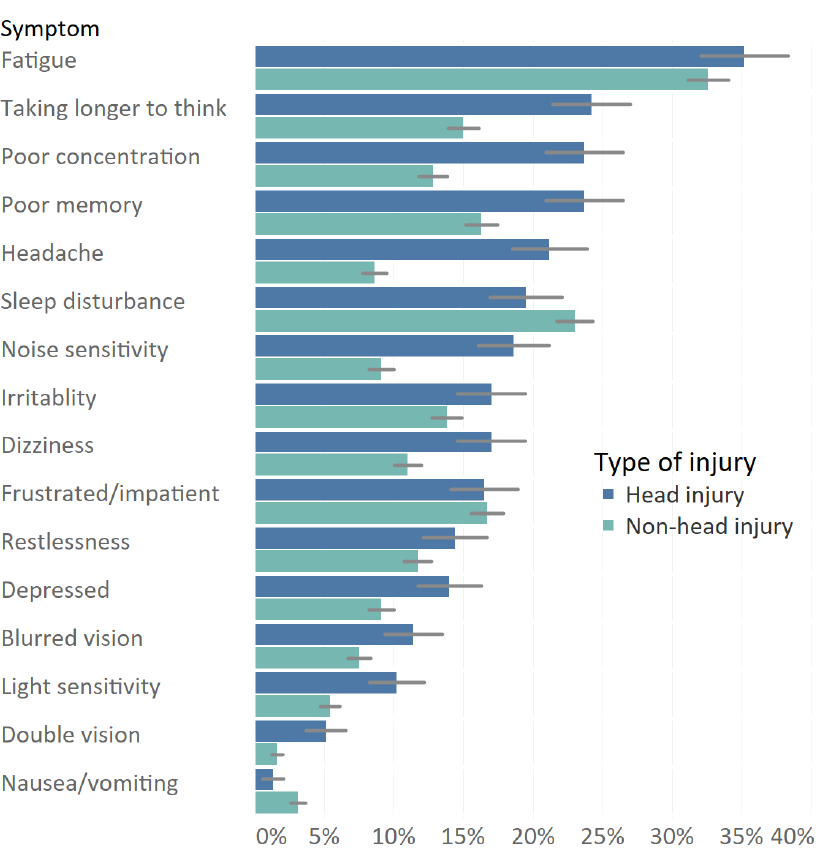
Figure 2. Frequency of post-concussion symptoms at twelve months post-injury. Error bars represent the standard error.